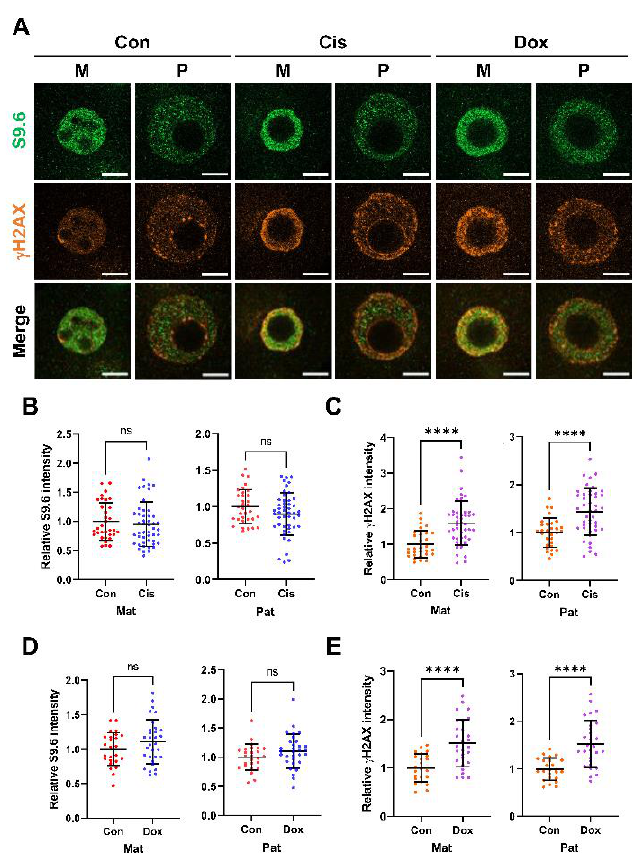
Figure 5. Increased γ H2AX levels did not affect the R-loop levels. ( A ) Single confocal optical section images of the maternal (M) and paternal (P) pronuclei from representative embryos. Zygotes were mock-treated (Con) and treated with cisplatin (Cis) and doxorubicin (Dox) from 4 hpi to 12 hpi (S-G2 phase). Immunofluorescence detection of the R-loop (S9.6 antibodies, green), γ H2AX (yellow), and merged image of these two channels (merged). M, paternal pronucleus; P, paternal pronucleus. All scale bars = 10 µM. ( B ) Quantification of relative S9.6 signal intensities in each maternal (Mat, left ) and paternal (Pat, right ) pronuclei. Con; n = 33, Cis; n = 48. ( C ) Quantification of relative γ H2AX signal intensities in maternal (Mat, left ) and paternal (Pat, right ) pronuclei. Con; n = 30, Cis; n = 43. ( D ) Quantification of relative S9.6 signal intensities in each maternal (Mat, left ) and paternal (Pat, right ) pronuclei. Con; n = 26, Dox; n = 48. ( E ) Quantification of relative γ H2AX signal intensities in maternal (Mat, left ) and paternal (Pat, right ) pronuclei. Con; n = 23, Cis; n = 28. This experiment was independently replicated three times. Statistical analysis was performed using an unpaired t-test. Error bars represent standard deviation. p -value: **** p < 0.0001; center values, mean; ns, not